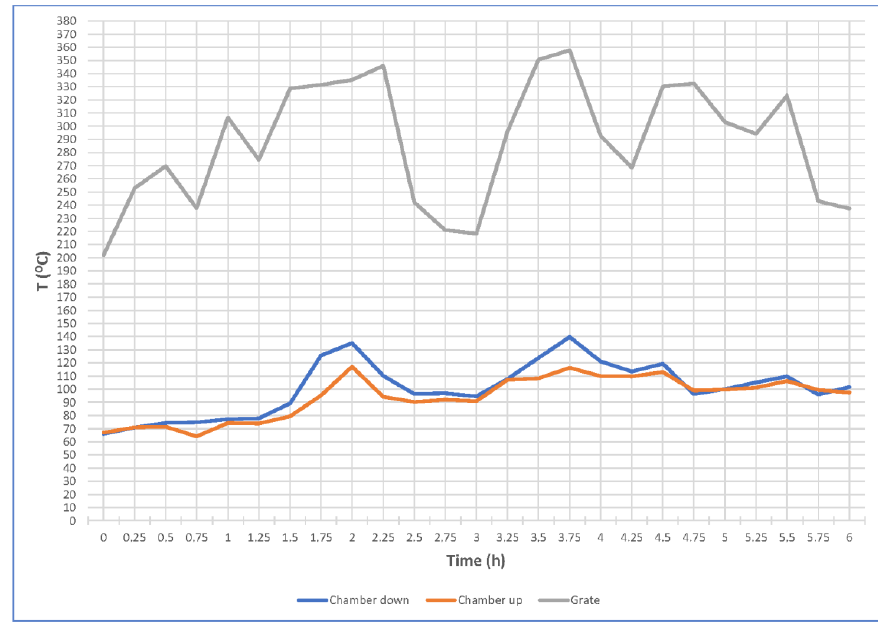
Figure 1. The temperature values (grate, top and bottom of the smoke chamber) obtained during smoking of medium ground sausages in variant A.